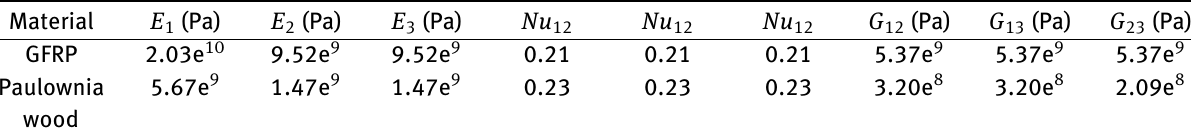
Table 2: Mechanical properties of GFRP and paulownia wood core used in FEM model.